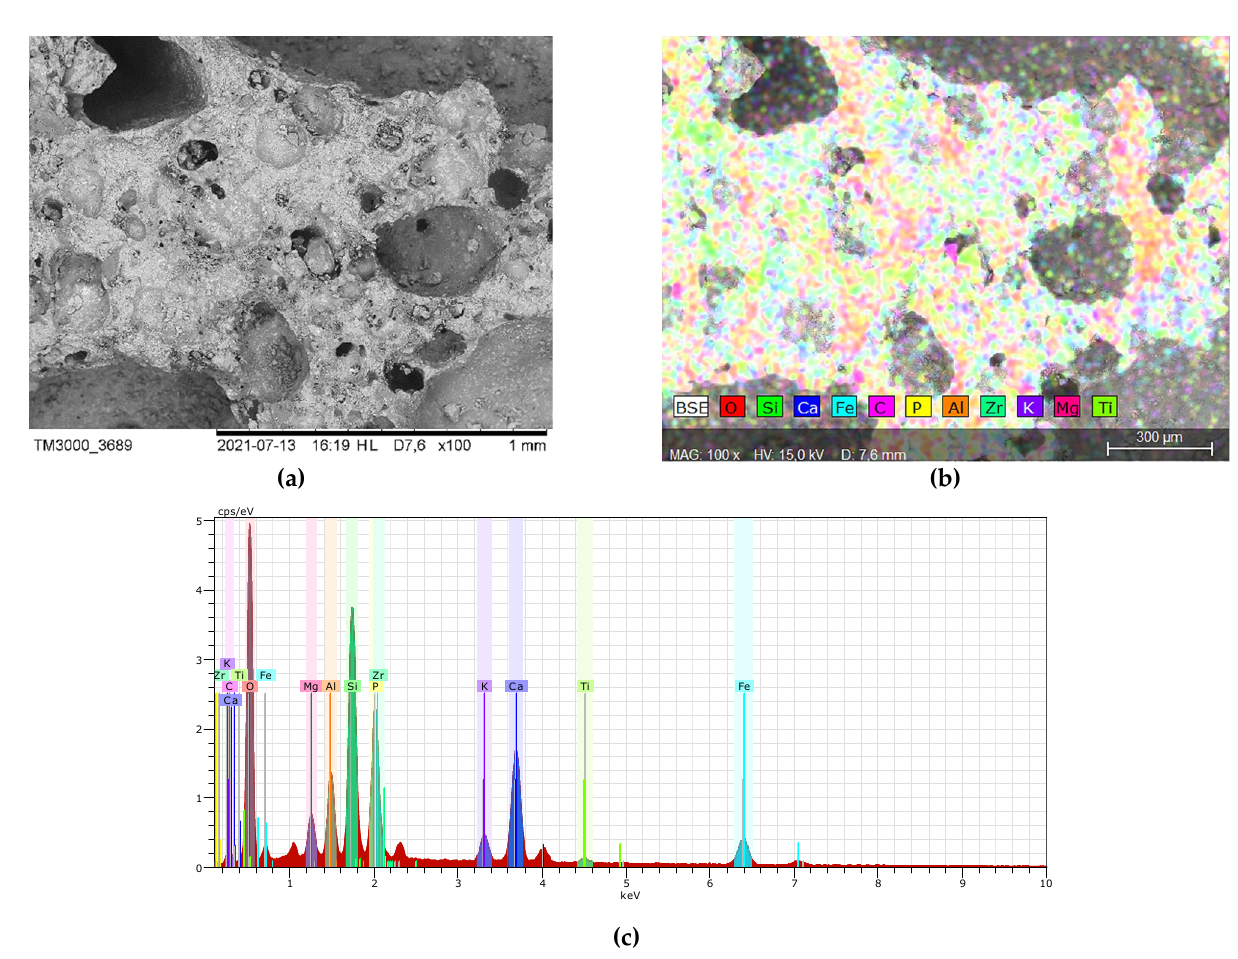
Figure 1. ( a ) Micrograph of the SS surface; ( b ) distribution of identified elements; ( c ) elements found in the SS.